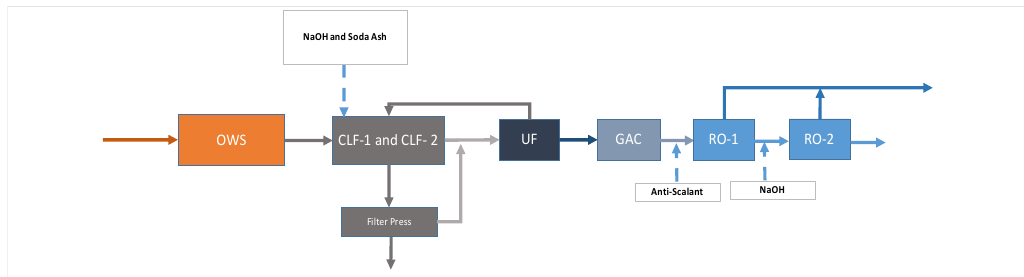
Figure 2. Process flow diagram for the pilot test system. Numbers in the figure indicate water quality sampling and process performance monitoring locations. OWS: oil–water separation; CLF: flocculation / clarification units; UF: ultrafiltration; GAC: granular activated carbon.